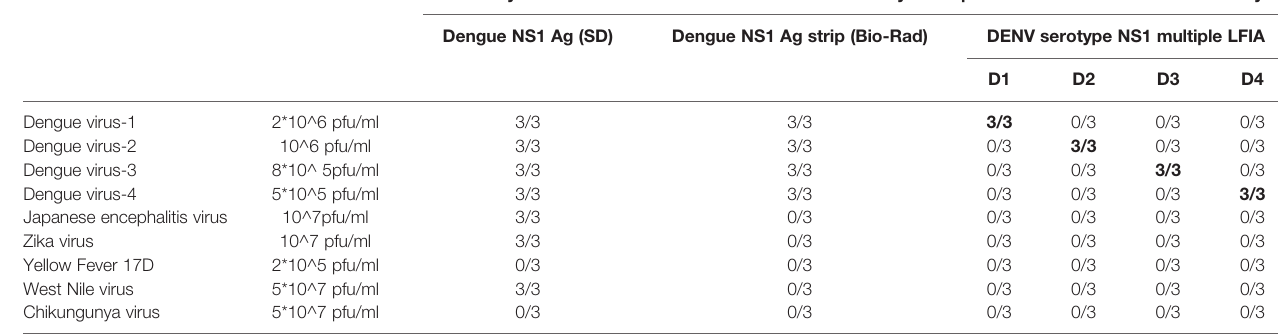
TABLE 3 | Cross-Reactivity (Analytic Speci fi